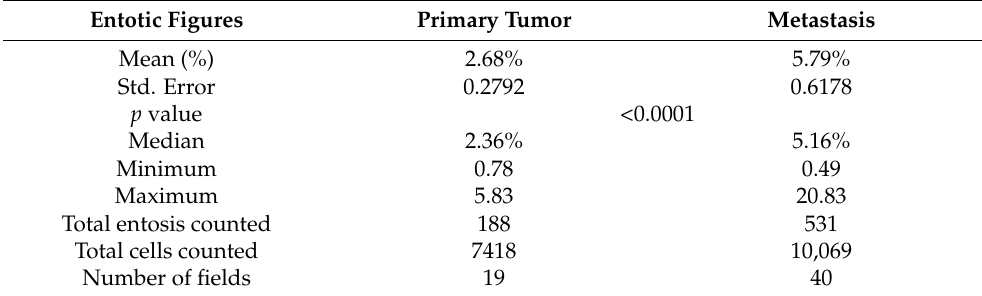
Table 3. Analysis of entotic figures calculated from slide scans (cells were positive for E-cadherin). Entotic